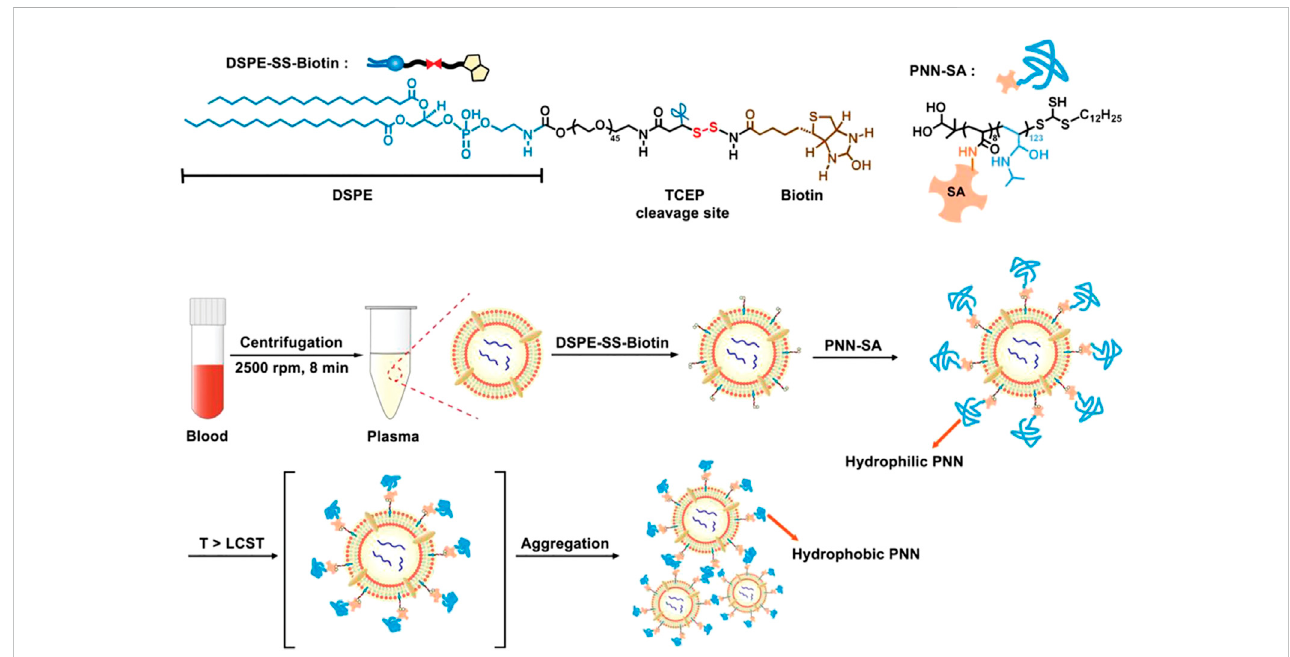
FIGURE 9 The molecular structures of PNN-SA and DSPE-SS-Biotin. DSPE-SS-Biotin can be inserted into the lipid bilayer of exosomes, and bare biotin interacts with PNN-SA to capture exosomes. The process is temperature-dependent. Reproduced with permission from (Zhang et al.,